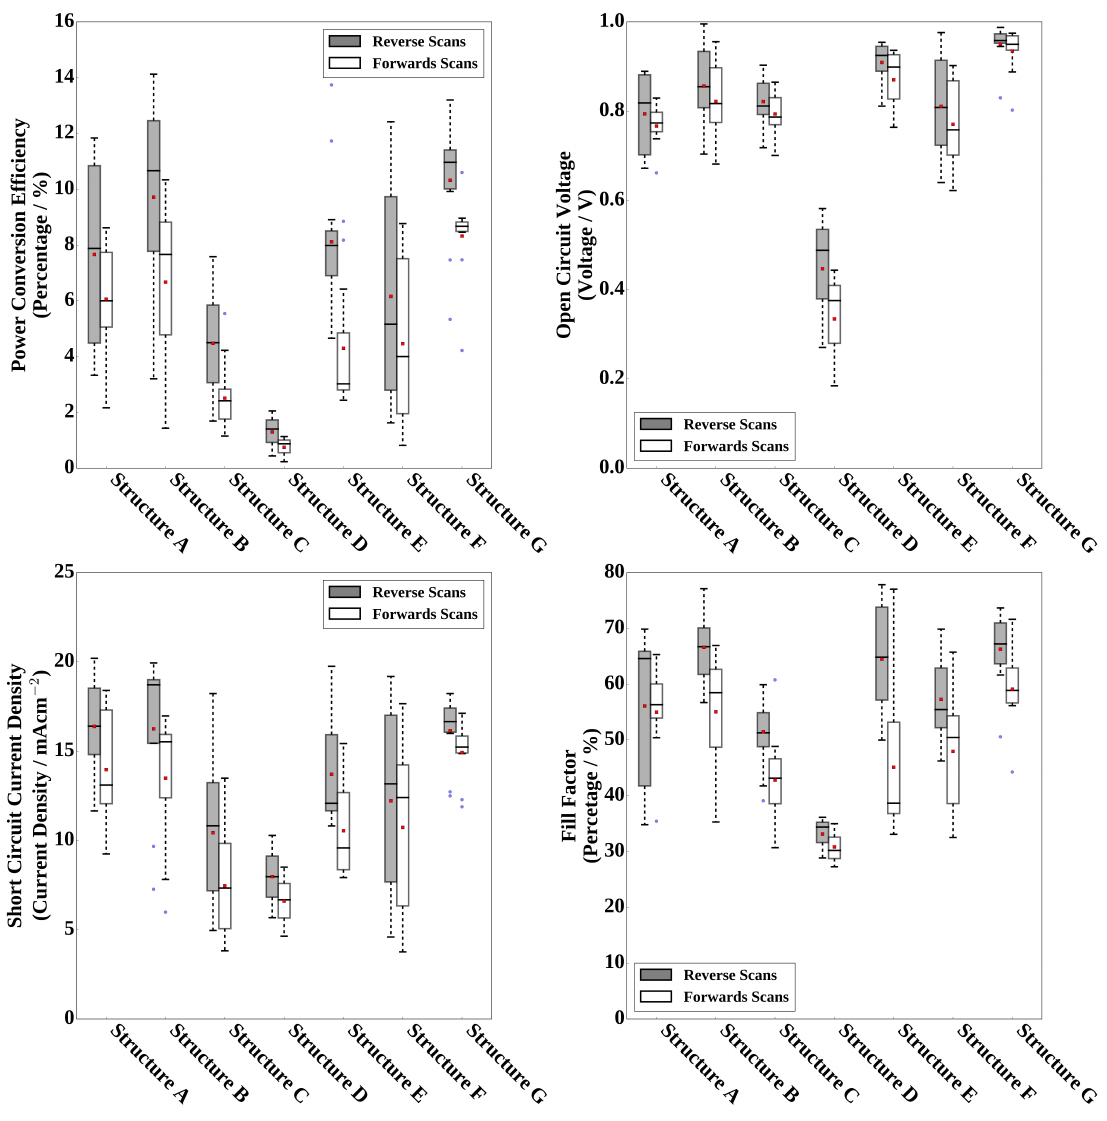
Figure 6. Box-plots of JV scan photovoltaic parameters for 0.09 cm 2 cells, see table for description of device structures. The boxes represent the first and third quartiles, the horizontal black line the median, the upper whisker the data within 1.5 times the inter quartile range of the upper quartile and the lower whisker 1.5 times the inter quartile range of the lower quartile, red square the mean and blue dots